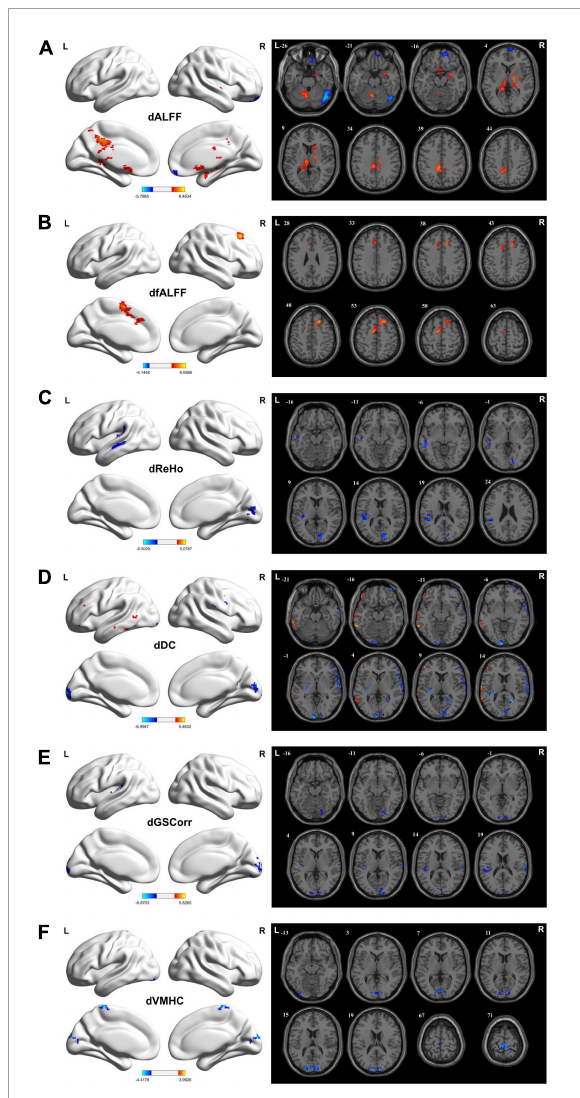
FIGURE2 Brain regions showing considerably altered dALFF (A) , dfALFF (B) , dReHo (C) , dDC (D) , dGSCorr (E) , and dVMHC (F) between patients with TLE and HCs. GRF corrected; voxel-wise P < 0.005, cluster-wise P < 0.05. The color bar indicates the t -value. Warm colors indicated increased indicator values, while cold colors indicated decreased indicator values. dALFF, dynamic amplitude of low-frequency fluctuation; dfALFF, dynamic fractional ALFF; dDC, dynamic degree centrality; dGSCorr, dynamic global signal correlation; GRF, Gaussian random field theory; HCs, healthy controls; dReHo, dynamic regional homogeneity; TLE, temporal lobe epilepsy; dVMHC, dynamic voxel-mirrored homotopic